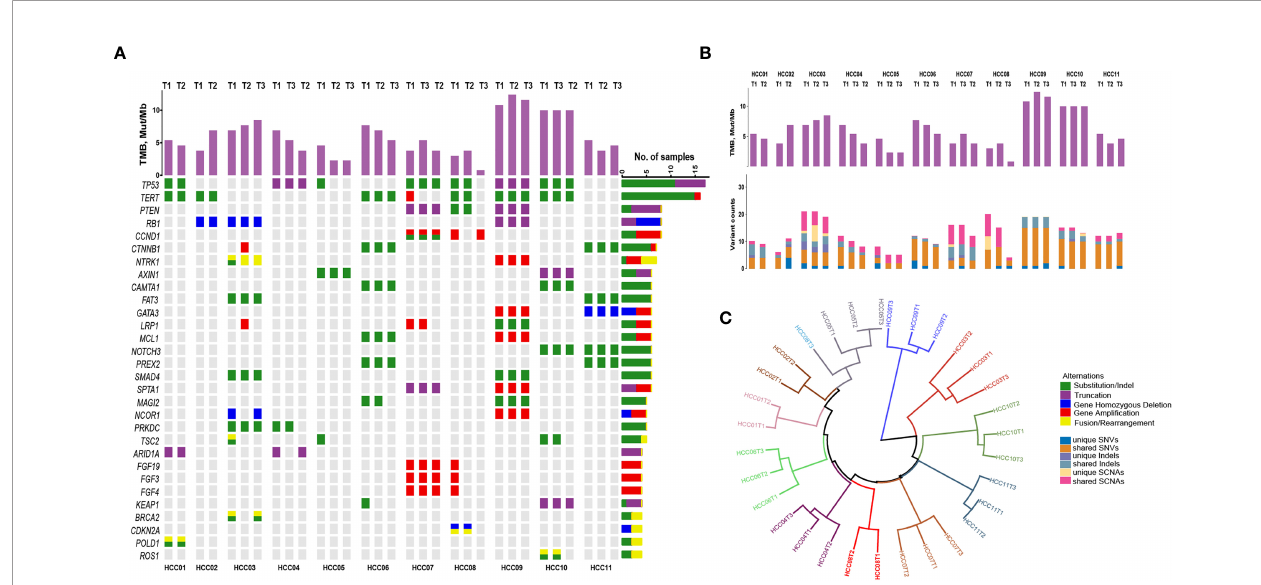
FIGURE 1 | The mutational landscape and spatial heterogeneity of genetic divergence in different tumoral focal from 11 patients with resected multifocal HCC. (A) Concordance among somatic alterations (SNVs, indels and SCNAs) in detected cancer-related genes through tNGS panel among different primary intrahepatic tumor lesions. Stacked bar plots illustrate the tumor mutation burden (TMB) value of each tumor. (B) The absolute counts of somatic mutations (SNVs, indels and SCNAs) that are shared or subfoci-unique in all multifocal HCC samples. (C) Hierarchical clustering of all HCC samples based on the mutational landscape. T3 of HCC08 is separated away from other foci in